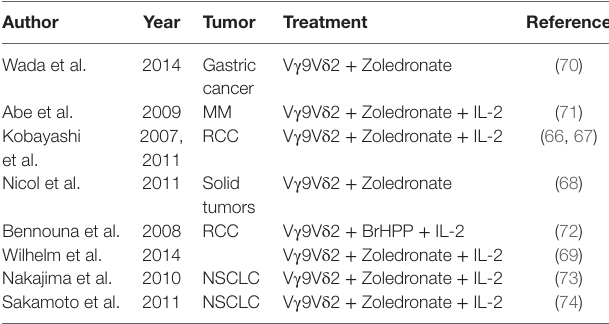
TABLe 2 | Survey of clinical trials based on adoptive transfer of ex vivo - expanded γδ